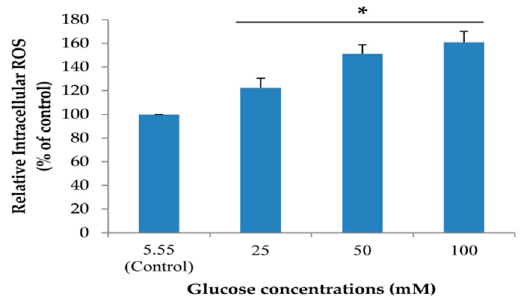
Figure 3. The effect of different concentrations of glucose on intracellular reactive oxygen species (ROS). Relative intracellular ROS level was performed using a microplate reader. Data are mean ± SD, * p < 0.05 vs. control. p values were 0.03, 0.007 and 0.000 for groups treated with glucose concentrations of 25, 50 and 100 mM, respectively.